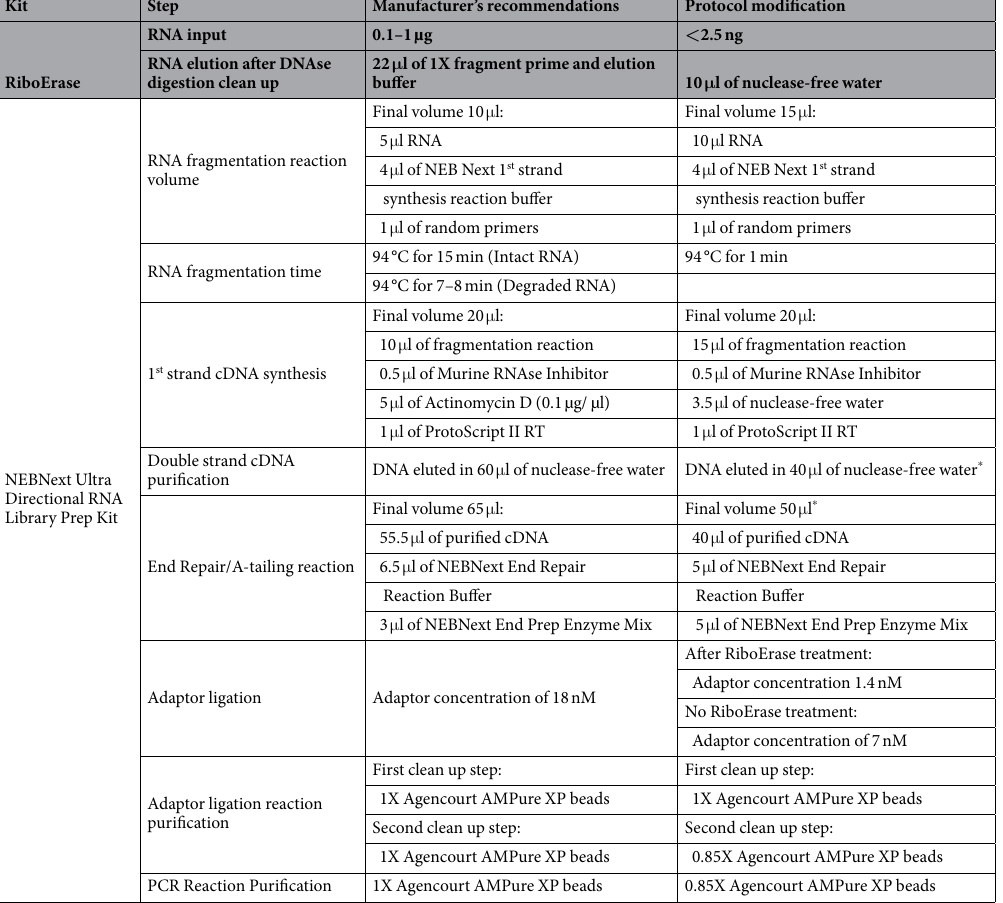
Table 2. Protocol modifications made to the RiboErase and NEBNext Ultra Directional RNA Library Prep kits. * Adjustments to the cDNA elution volume and the A-tailing reactions follow Batty et al . 69